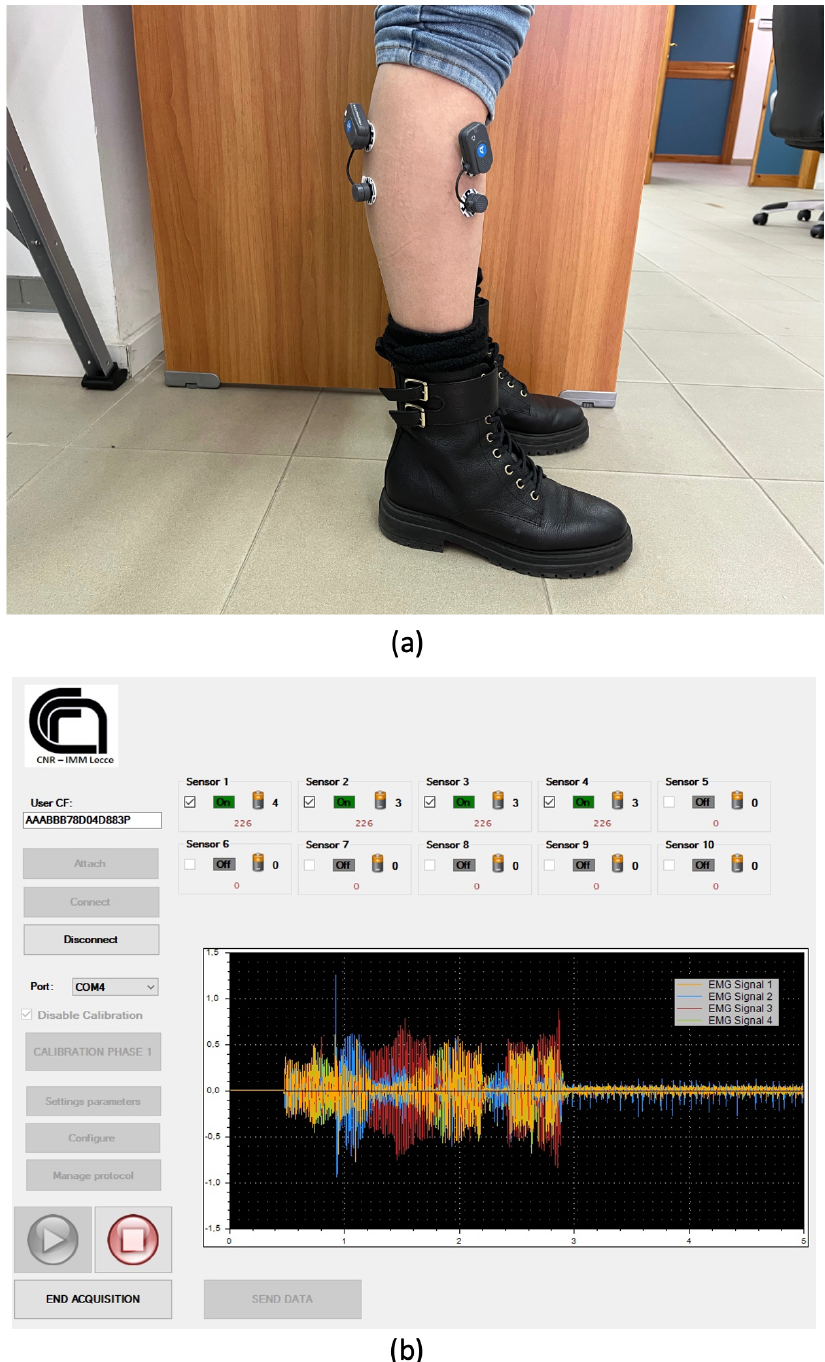
Figure 2. ( a ) Positioning of the electrodes on Gastrocnemius Lateralis and Tibialis Anterior muscles; ( b ) software interface developed for raw sEMG data acquisition and